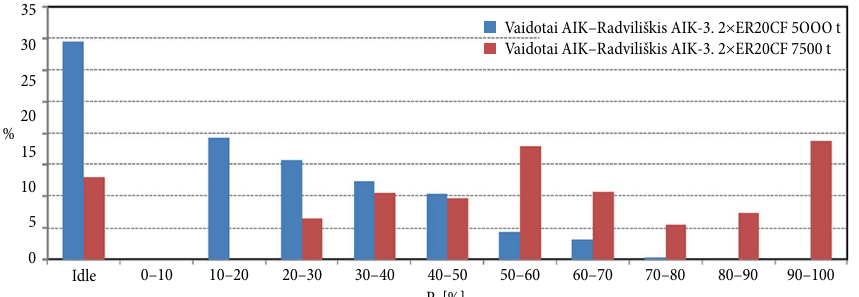
Fig. 4. Operational load cycle structure of the 2ER20CF locomotive diesel engine on the line Vaidotai–Radviliškis (train weight 5000 t and 7500 t) Table. Comparative harmful component emission originating from diesel engines of freight locomotives operated by the JSC ‘Lithuanian Railways’ on the main railway network lines Engine model (locomotive)